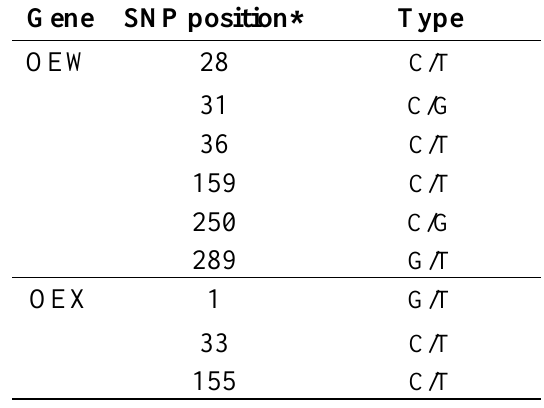
Table 1. Position and types of the nine SNPs discovered.